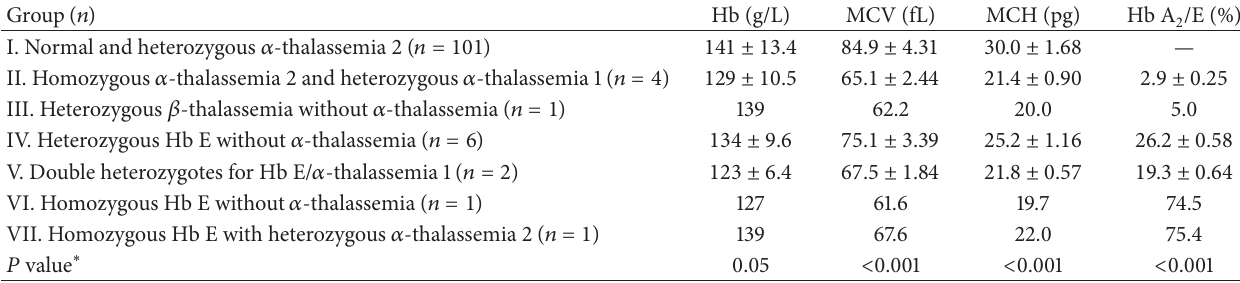
Table 3: Hematological findings of normal and different types of thalassemia and Hb E.